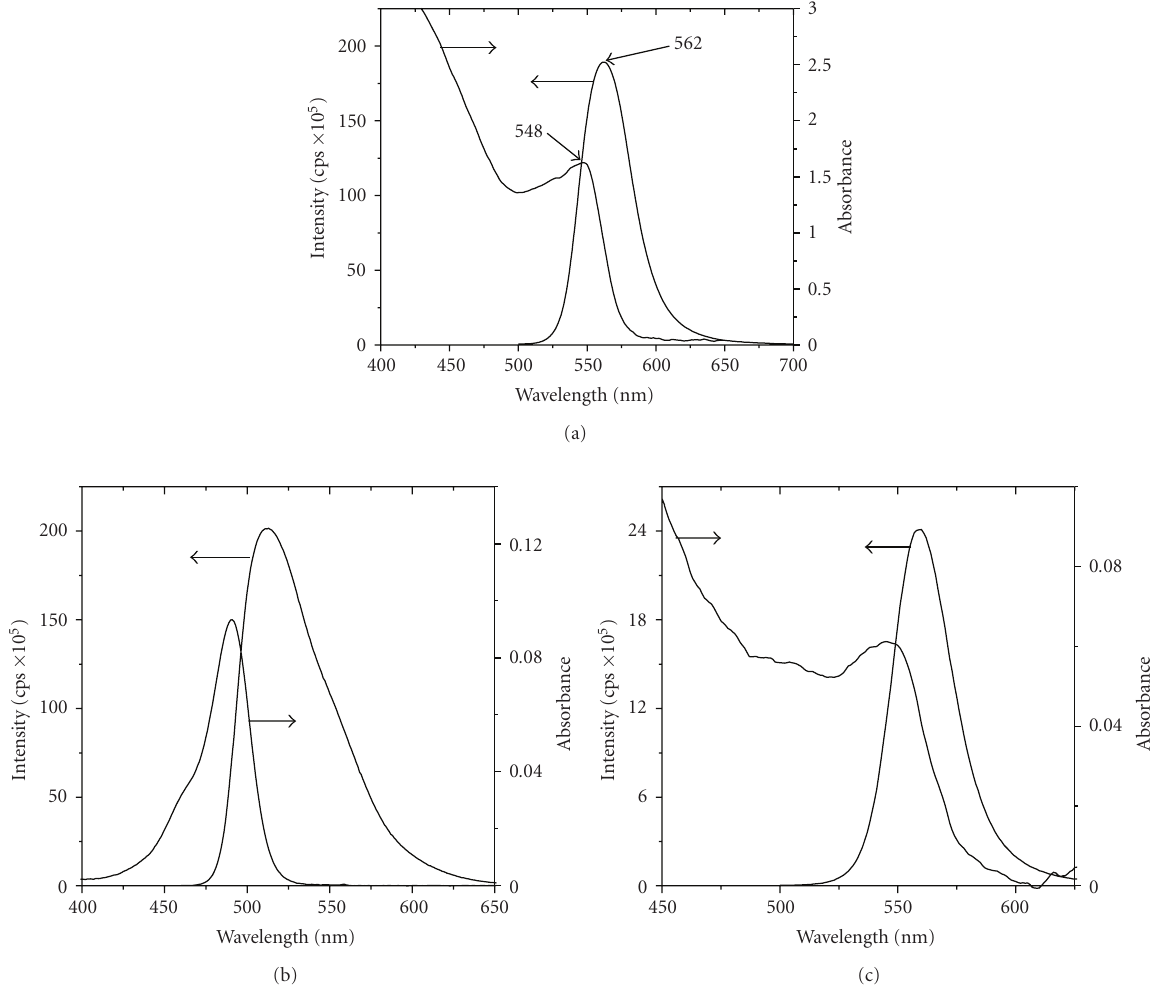
Figure 1: (a) Absorption and emission spectra of DHLA-capped QDs. Fluorescence spectrum was obtained using a quartz cell with an optical path length of 1 cm, excitation wavelength at 467 nm, and 2, 2 nm slit width at the excitation and emission, respectively; (b) UV-vis and fluorescence spectra for fluorescein; (c) DHLA-capped QDs used for quantum yield